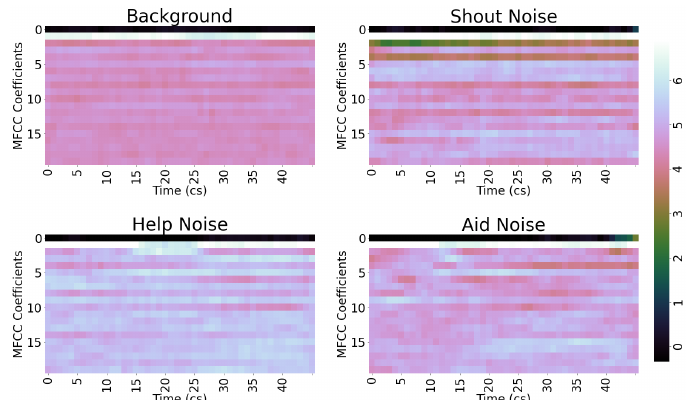
Figure 4. Mel Frequency Cepstral Coefficients in a window of 45 cs for each category. Horizontal axis corresponds to time and vertical axis corresponds to the magnitude of the coefficients. Darker colors indicate lower magnitude